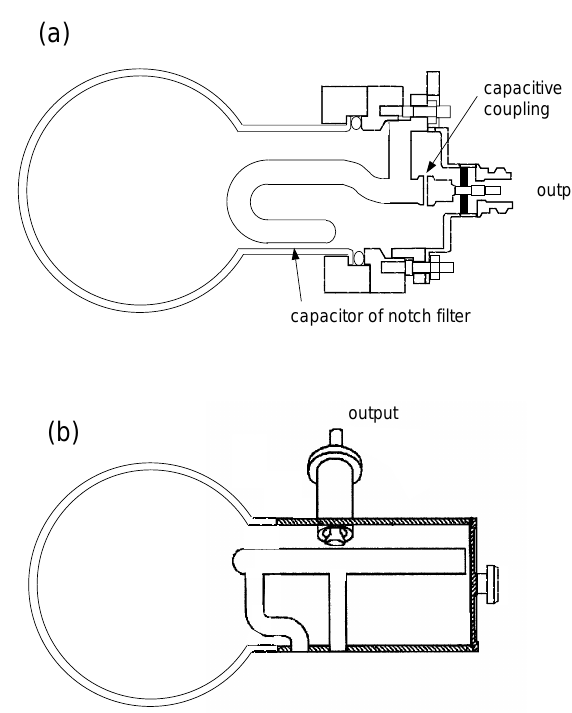
FIG. 11. The higher-order-mode couplers: (a) demountable HOM coupler and (b) welded HOM